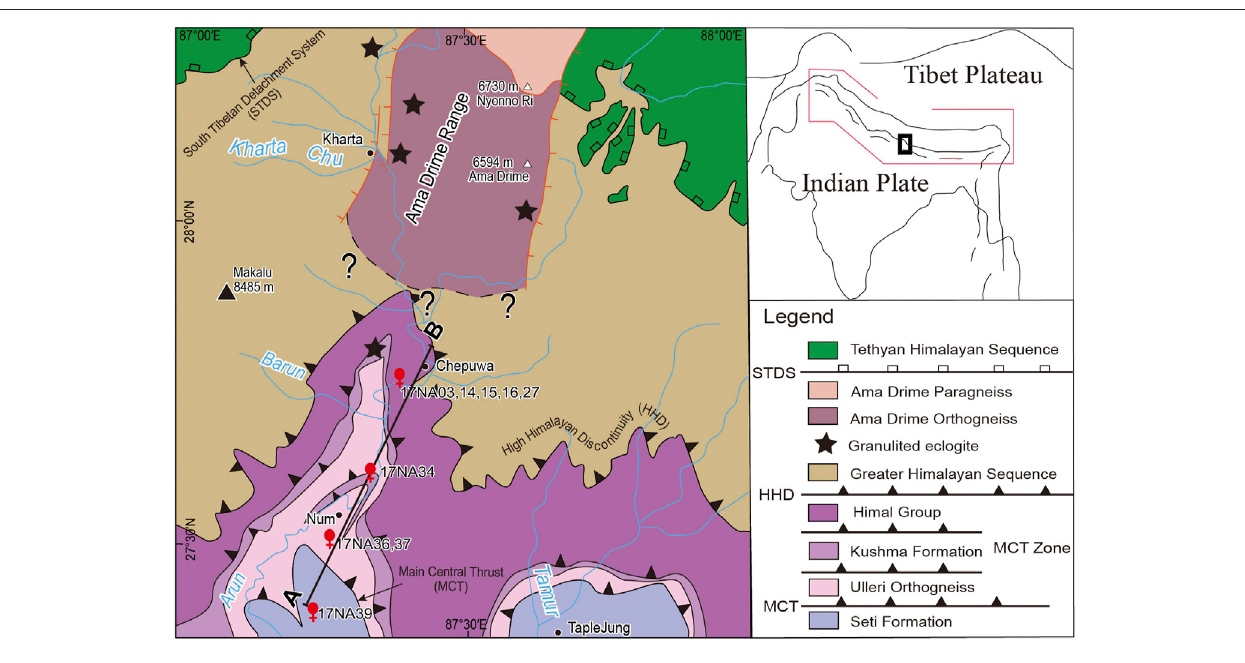
FIGURE1| Geological map ofnortheasternNepalfrom theArun Valley totheAma Drime Range, modi fi edfrom the studyby Kaliet al.(2010) and Goscombe et al. (2018).TheMainCentralThrust(MCT)hasbeenmappedinthesamelocationastheRamgarhThrustbyGoscombeetal.(2018).Pro fi leA – Bisin Figure2 .STDS,South Tibetan detachment system; HHD, high Himalayan discontinuity.